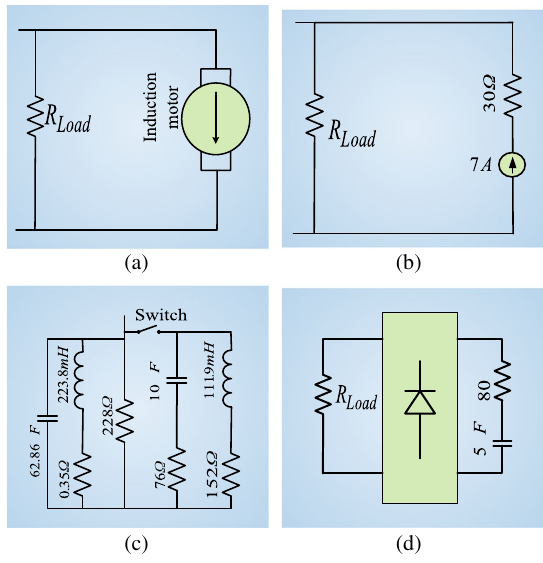
Fig. 16 Inclusion of ( a ) Asynchronous Machine Load, ( b ) Harmonic Load, ( c ) Unknown Load, ( d ) Non-linear Load with Microgrid